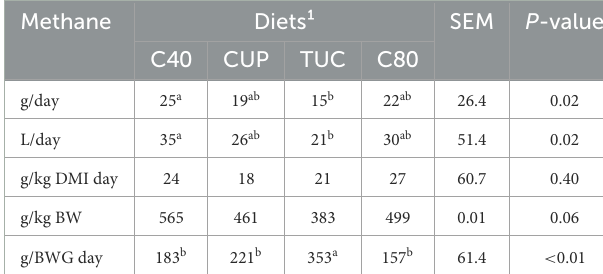
TABLE 4 Methane emissions in confined sheep with diets containing Amazonian cakes (CUP and